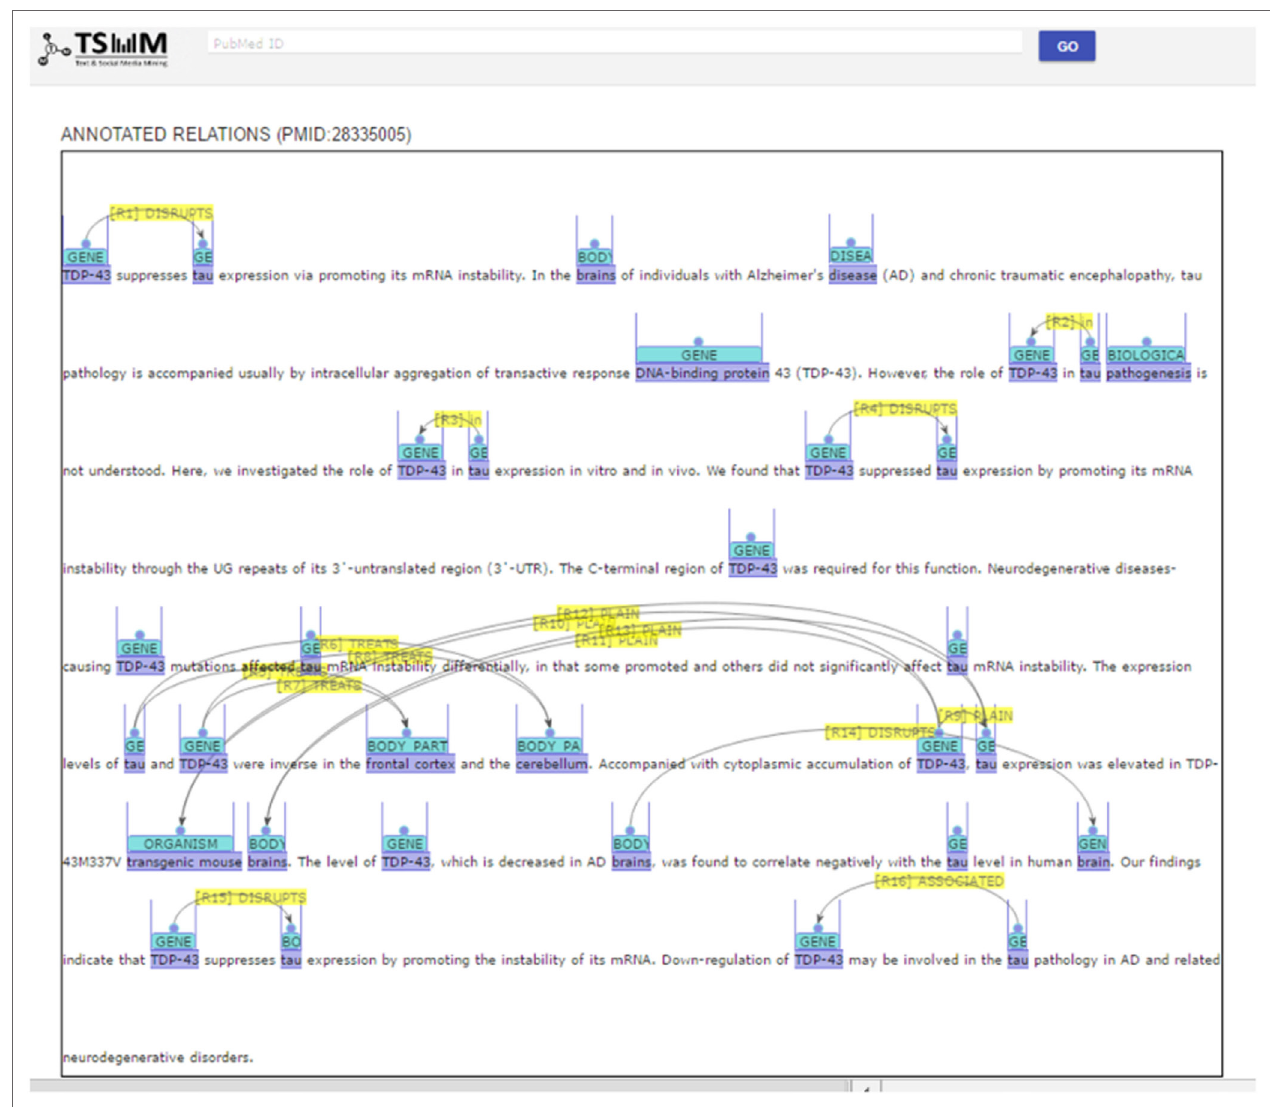
FigUre 10 | Examples of the results’ page of the search engine: an annotated